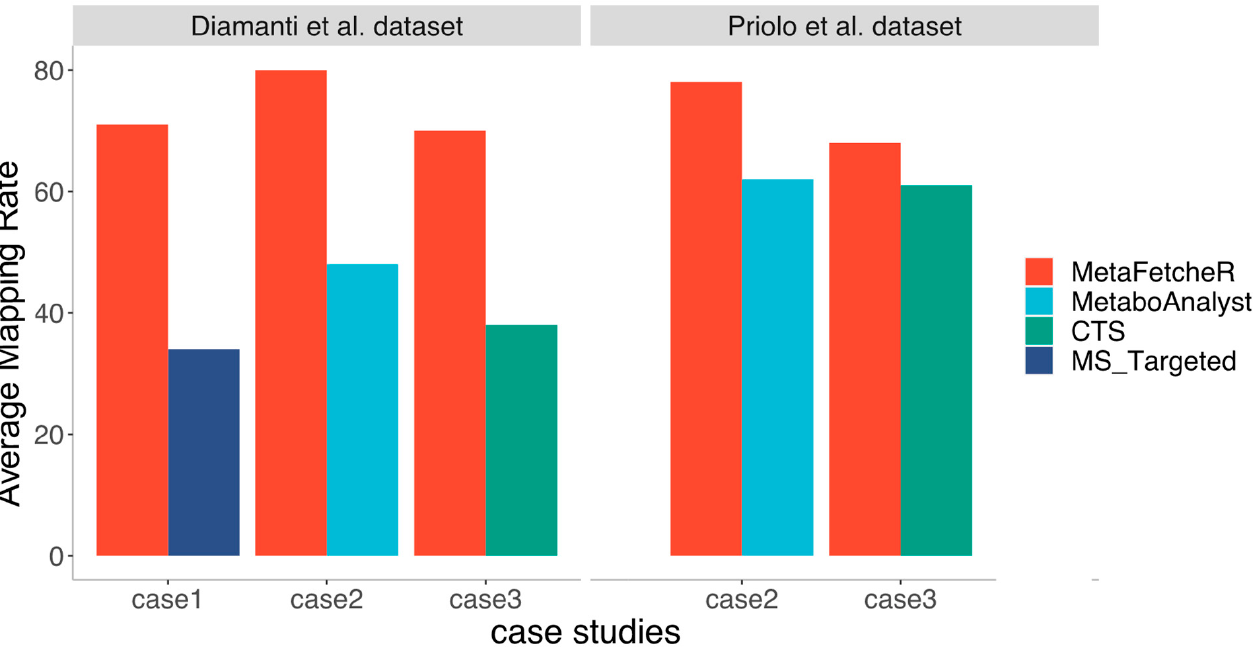
Figure 3. Comparison of the mapping performance for the three tools with the mapping performance of MetaFetcheR. The comparison utilizes the data from the three case studies performed on the two datasets from Diamanti et al. [1] and Priolo et al. [12].